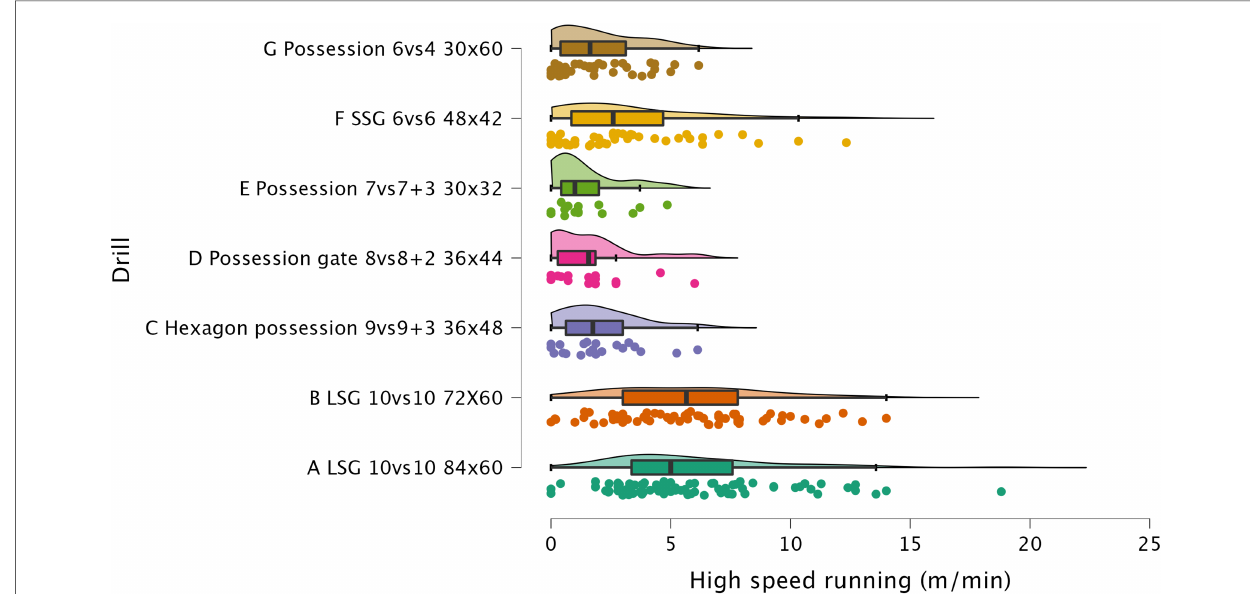
FIGURE 2 Comparison of HSR per minute between drills. The data distributions show, mean, standard deviation, 95% con fi dence intervals, and individual data points.